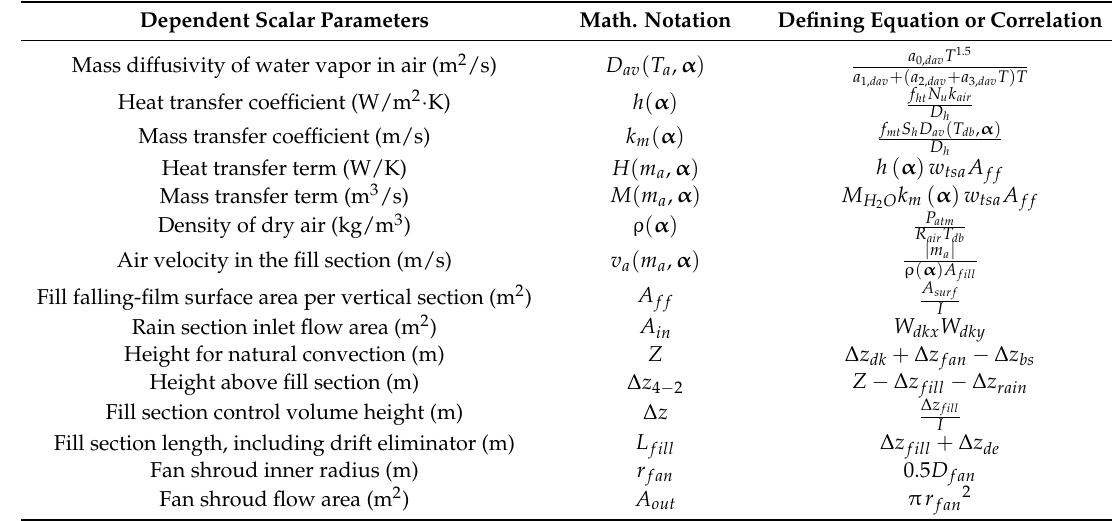
Table B2. Dependent scalar model parameters.